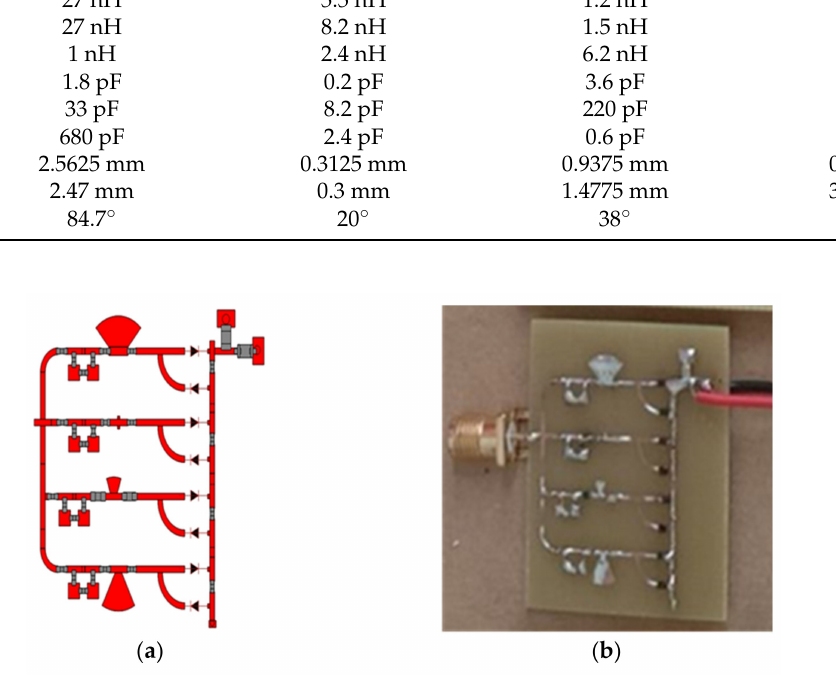
Figure 16. The optimized ( a ) layout and ( b ) prototype image of the four-band rectifier topology. The active area of the PCB is 32.07 mm × 35.75 mm.